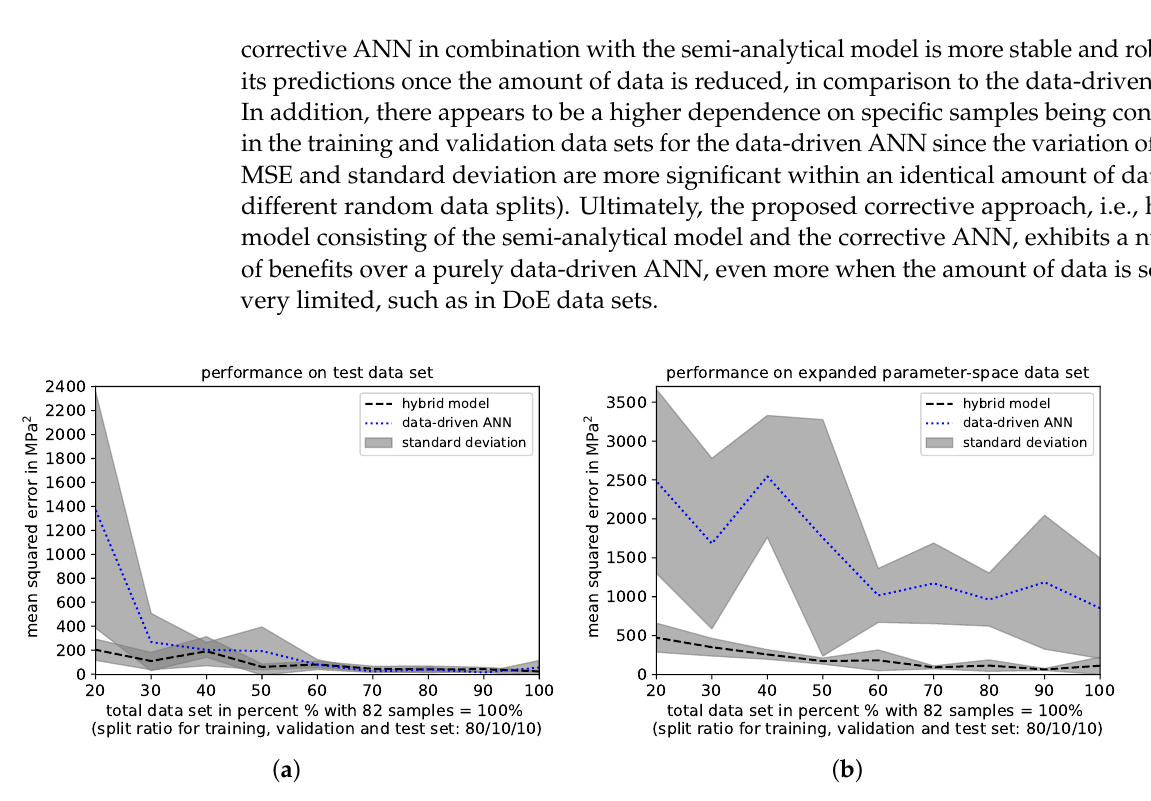
Figure 13. Comparison of prediction performances of hybrid model and direct ANN with respect to the average mean squared error (MSE) and standard deviation achieved on ( a ) the test data set and ( b ) the extrapolation data set, while reducing the amount of the total data set (training, validation and test data sets) from 100% to 20% in increments of 10%-steps, respectively. All MSE average values and standard deviations are based on three different MSEs and their respective standard deviations that are achieved on dissimilar data splits implemented by changing